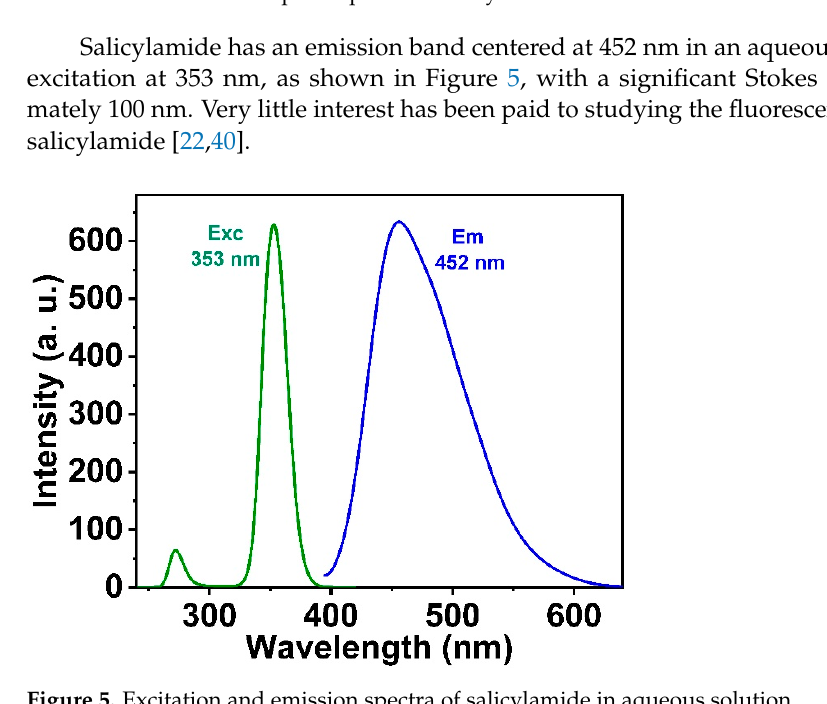
Figure 4. ( a ) Absorption spectra of salicylamide in aqueous solution at different pH values; ( b ) cal- ibration curve of the absorption spectra of salicylamide.